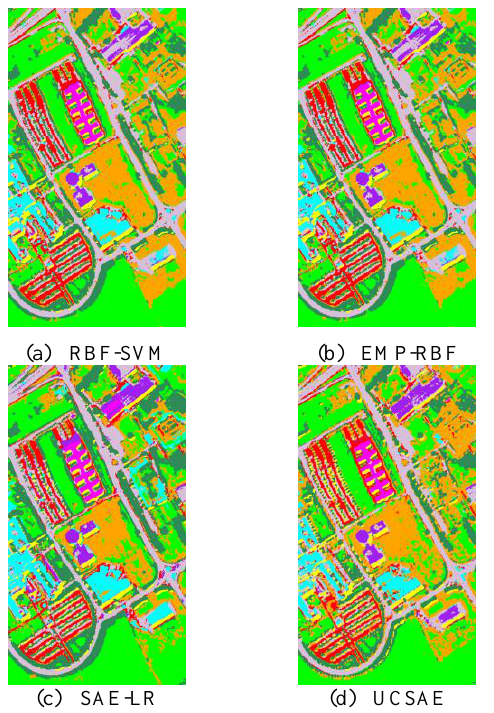
Figure 5 The classification maps for the different spatial- spectral classification methods.